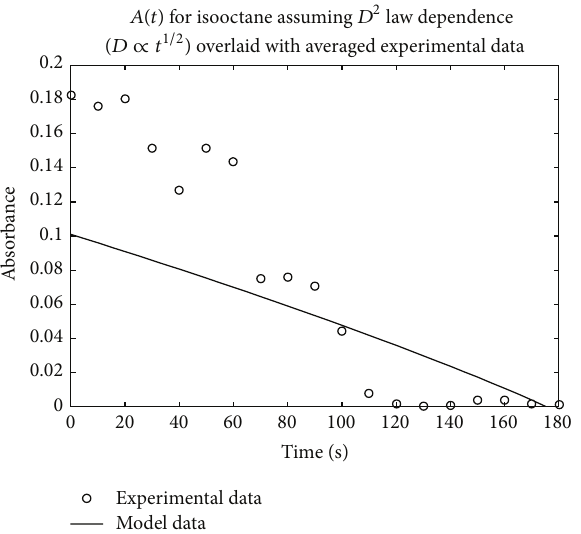
Figure 5: Single component droplet evaporation comparing the experimentaldatafromIRabsorptionspectroscopyofourmodelfor 100% isooctane. Data shown were averaged over five experiments.